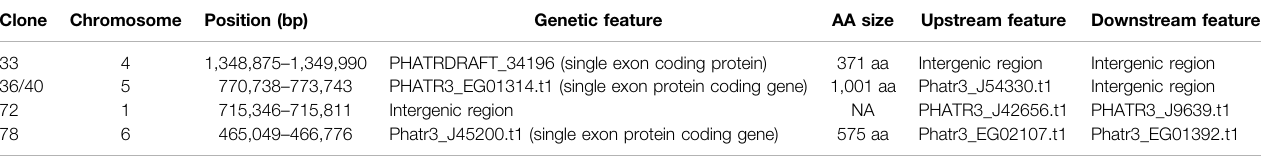
TABLE 2 | Summarized details of integration sites of clones harboring a functional single-copy integrated transgene. Clone Chromosome Position (bp) Genetic